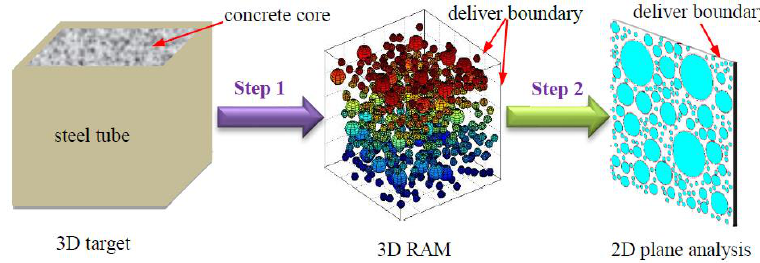
Figure 4. The procedures for simplifying the 3D models to the 2D plane analysis. Sensors 2019 , 19 , x FOR PEER REVIEW